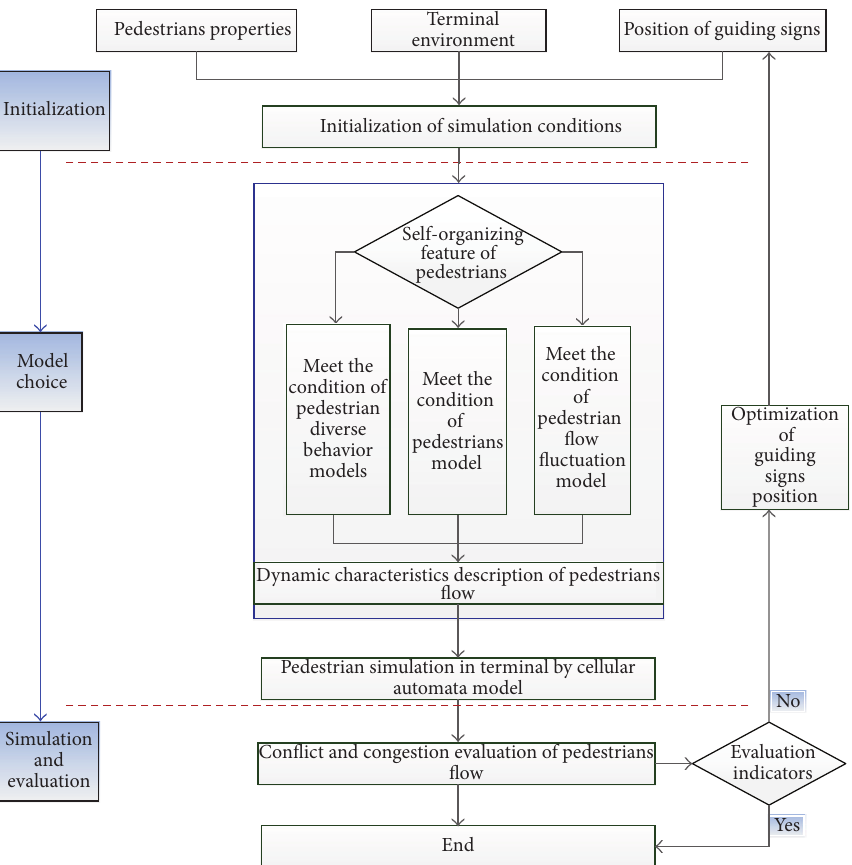
Figure 1: The optimization framework of pedestrian guiding sign